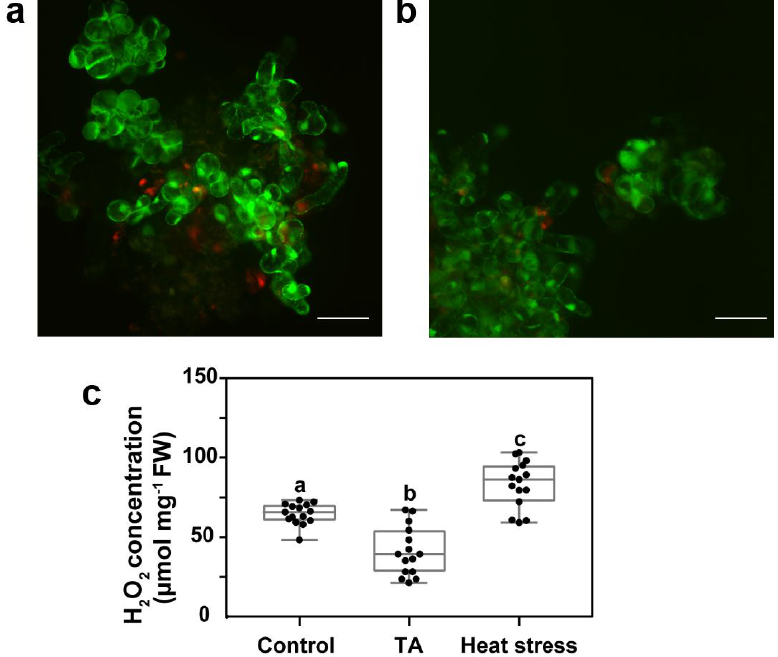
Figure 1. Detection of a reactive oxygen species (ROS). ( a ) ROS were detected using H 2 DCFDA (green) in Arabidopsis suspension cells treated for 24 h with 0.1% methanol (Control) or ( b ) with 1 µM thaxtomin A (TA). Scale = 100 µm. ( c ) H 2 O 2 concentration was measured in µmol·mg −1 fresh weight (FW) using a modified FOX assay in cells treated for 24 h with 0.1% methanol (Control), 10 µM thaxtomin A (TA), or at 45 °C for 30 min (Heat stress). Values represent 15 measurements from three independent experiments. The three groups were compared using Dunnett’s multiple comparison test. Different letters indicate statistically significant differences, p < 0.05.